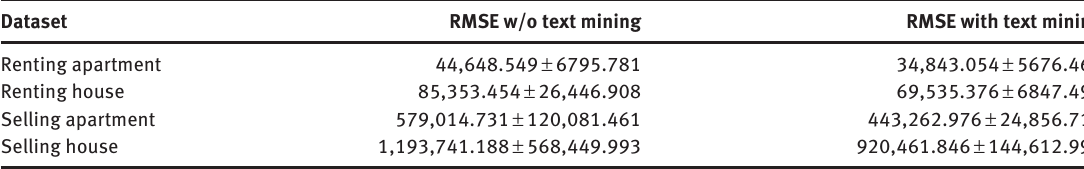
Table 5: RMSE when ANN Regression Was Used in the First Stage of Our Two-Stage Regression Model. Dataset